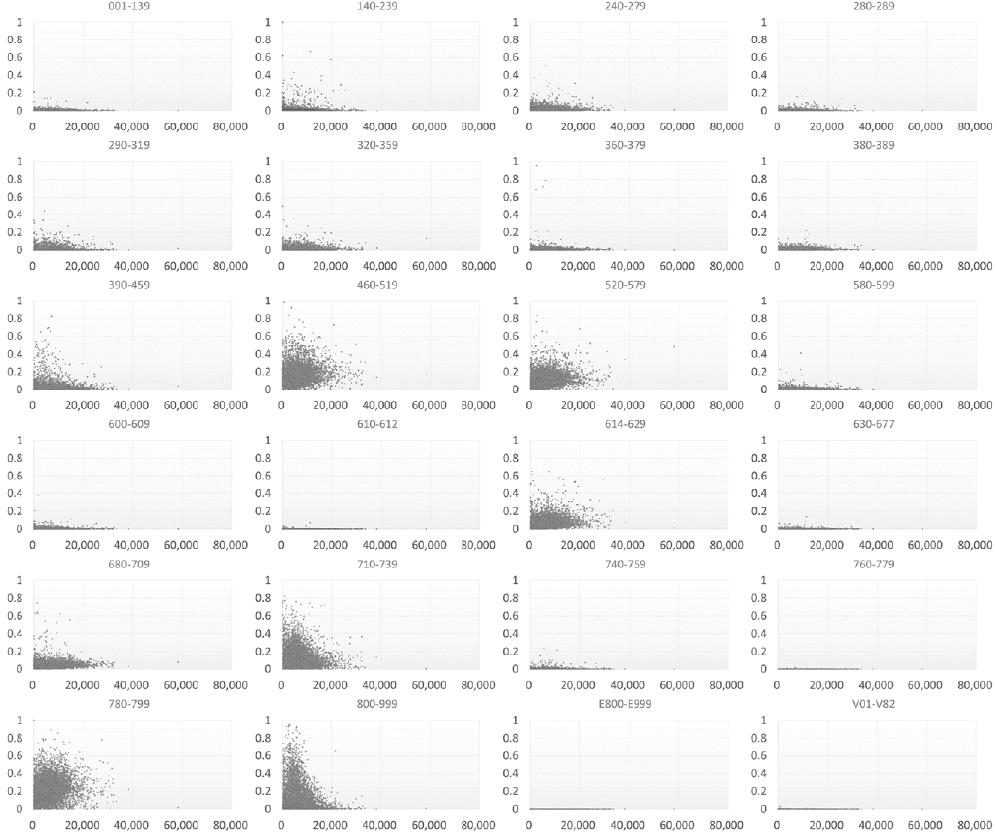
Figure 10. Distribution of ICD-9-CM codes with total visit counts by each TCMP. A larger proportion indicates that TCMPs used more ICD-9-CM codes within a specific range in patient data.